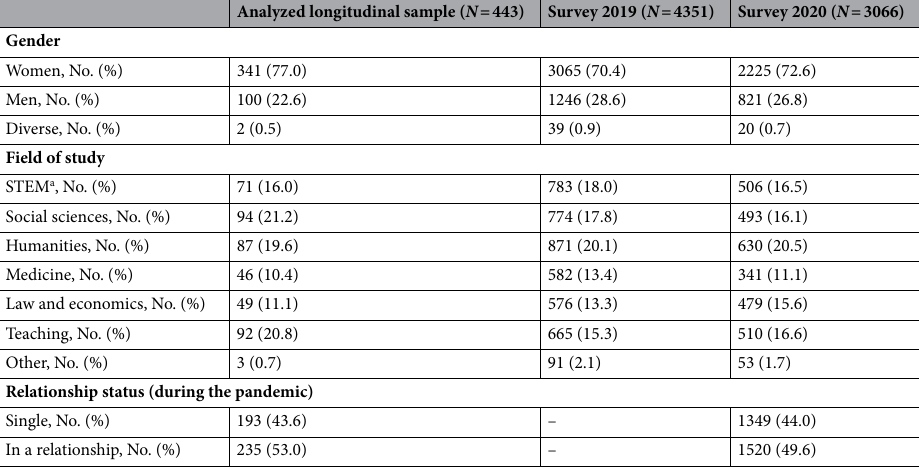
Table 1. Frequencies of gender and field of study in the study sample before and during the pandemic. a Science, Technology, Engineering, and